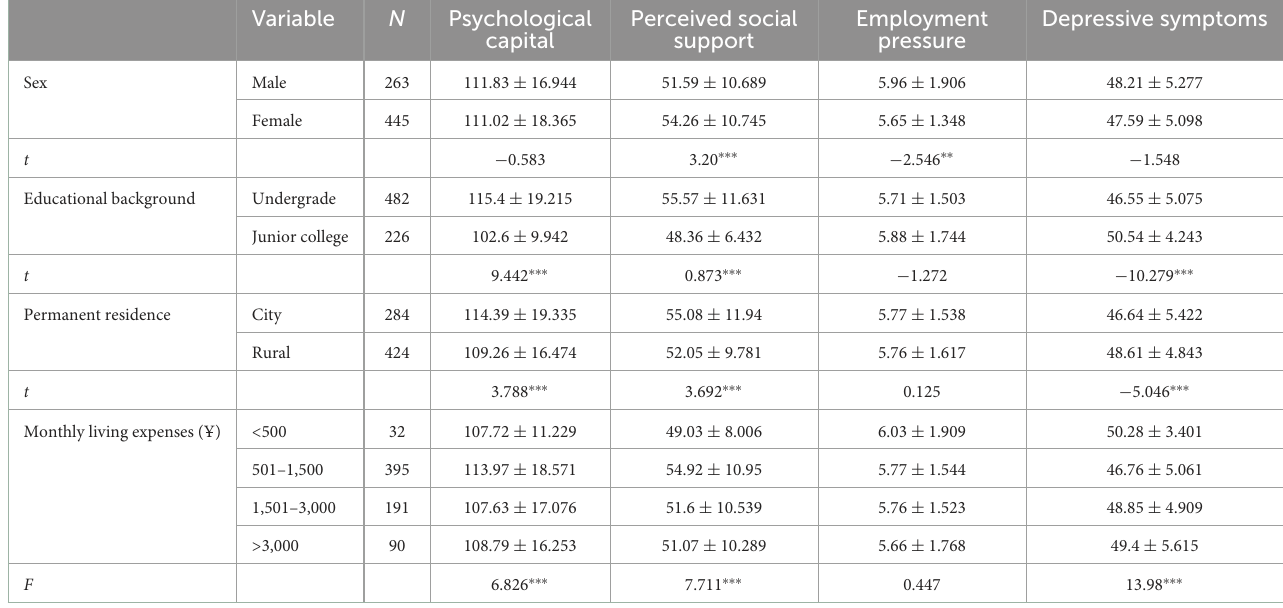
TABLE 1 Means, standard deviations, T -test, and ANOVA test among study variables.